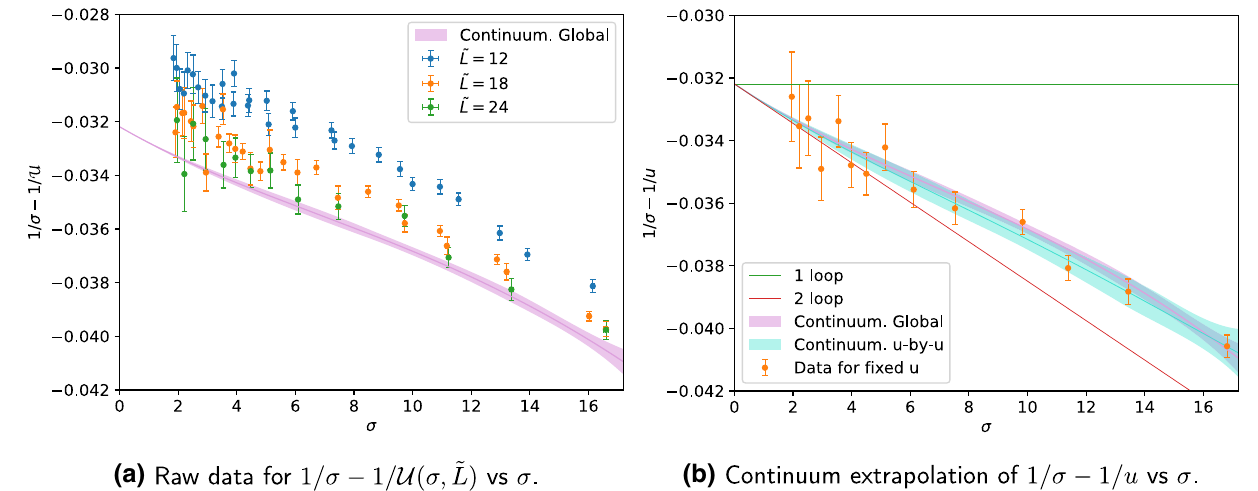
Fig. 2 a Raw data for the inverse step scaling function compared to the continuum extrapolation obtained from the global fit, cf. Eqs. (3.21), (3.22). b We display the comparison between various con- tinuum extrapolations of 1 /σ − 1 / u vs σ . The orange data points cor- respond to the determination at fixed values of u given in Table 1. The